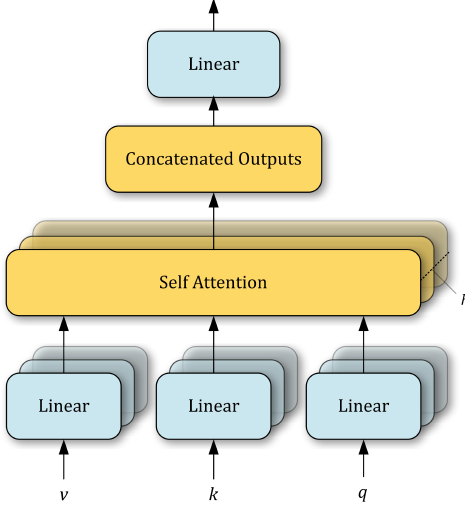
Figure 9. Block diagram of the multi-head self attention mechanism.